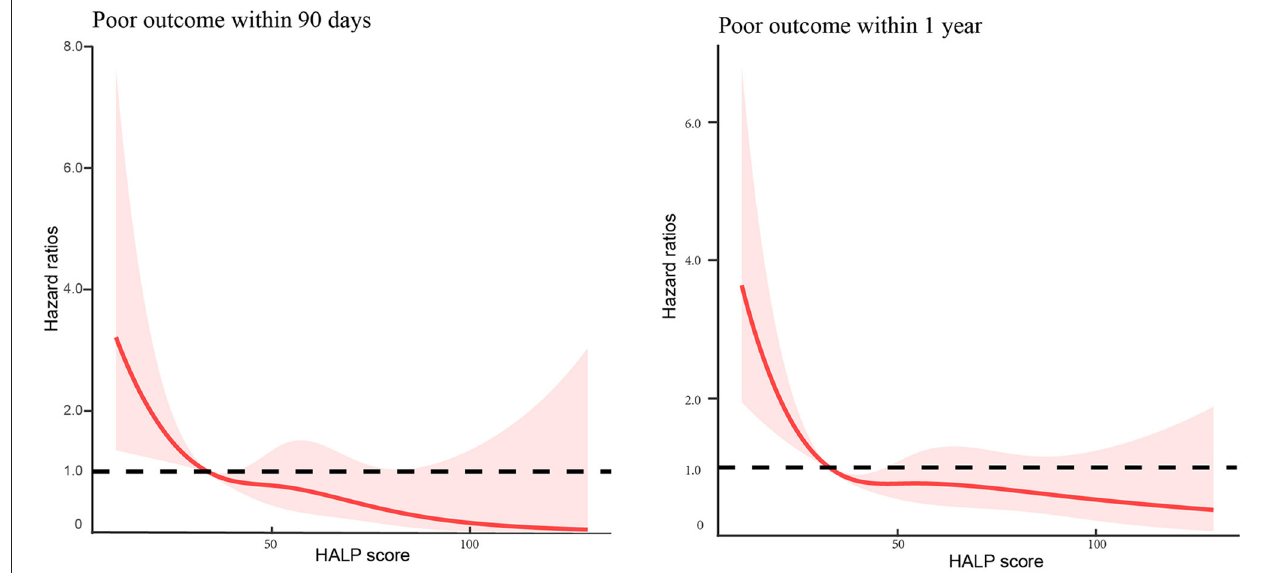
FIGURE 3 | Association of hemoglobin, albumin, lymphocyte, and platelet (HALP) score with the risk of poor outcome among patients with acute ischemic stroke at 90-day and 1-year follow-up.